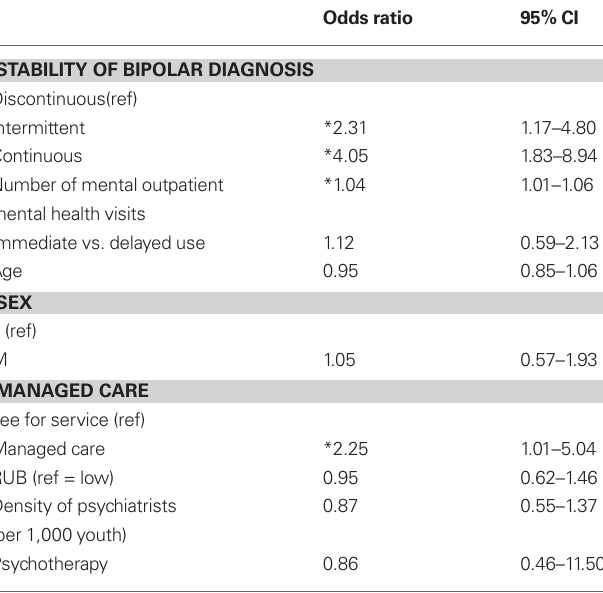
Table 3 | logistic regression model for probability of continuity of mood stabilizing medication treatment by stability of bipolar disorder diagnosis over 6-month follow-up period ( n =